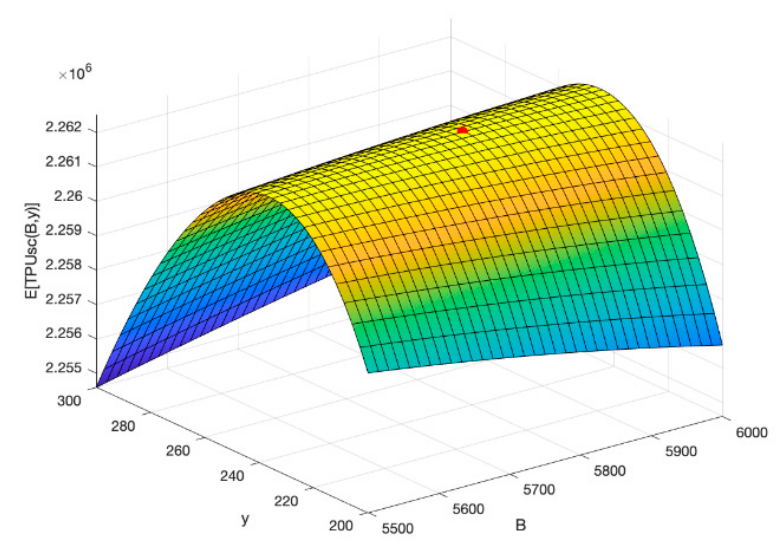
Figure 10. Concavity of E [ TPU SC ( B , y )] w.r.t. B , y .